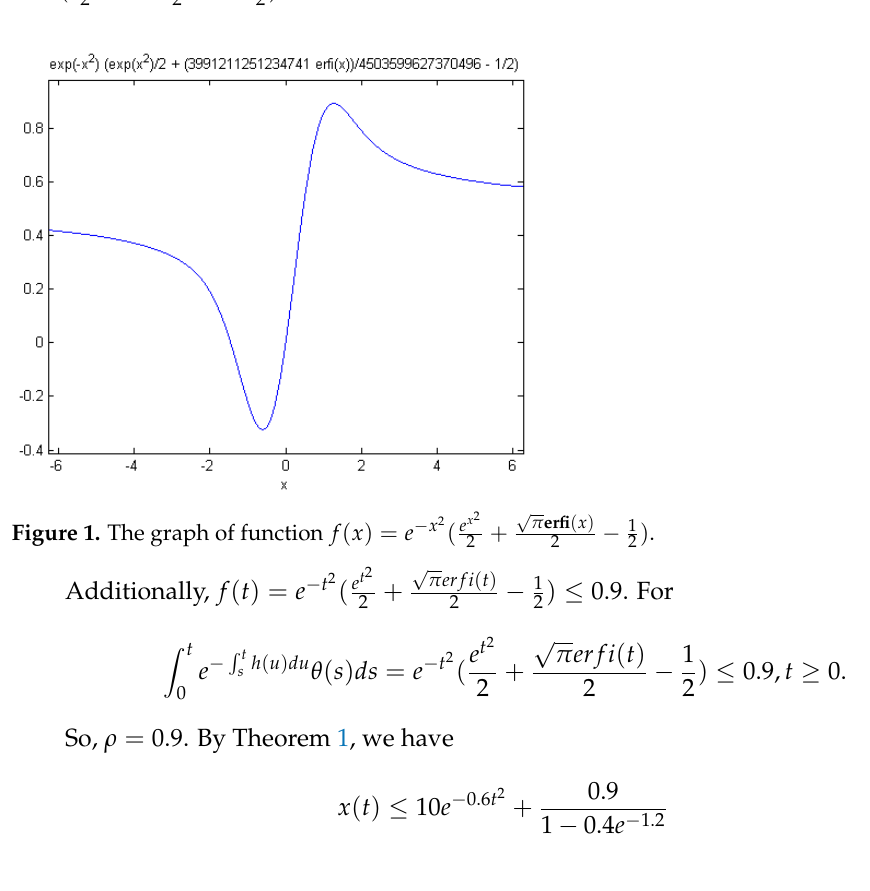
Figure 1. The graph of function f ( x ) = e − x 2 ( e x